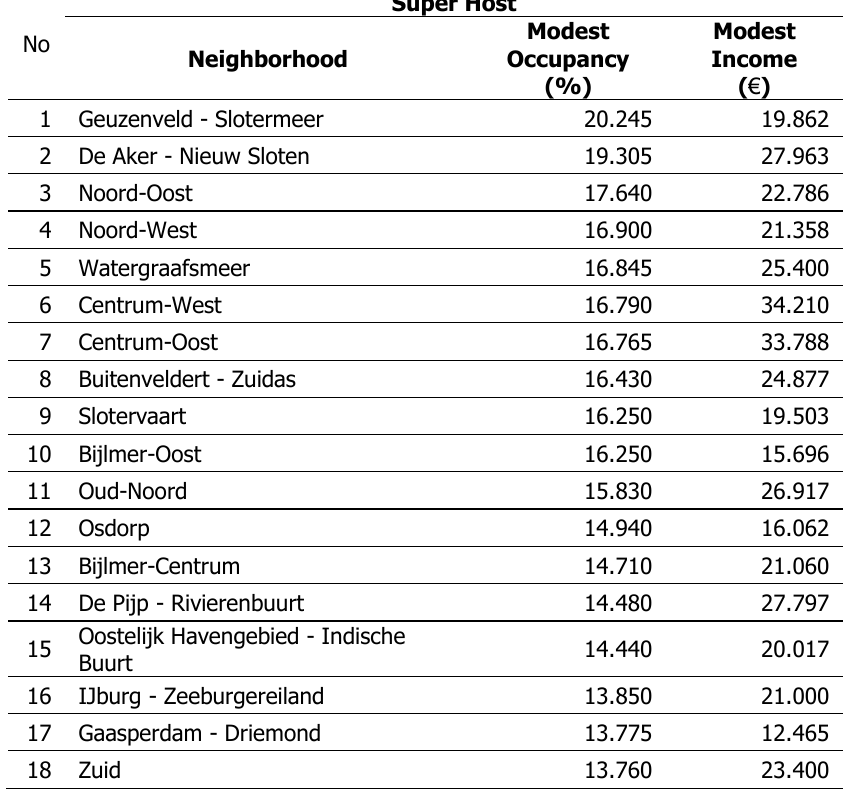
Figure 7. Income by area and host status Table 3 . Super Host Monthly Occupancy Rate and Yearly Income By